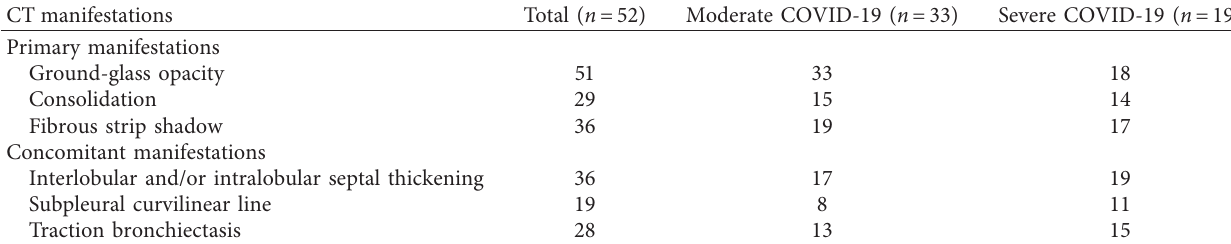
Table 2: CT manifestations of 52 patients with COVID-19 at the last time of admission.